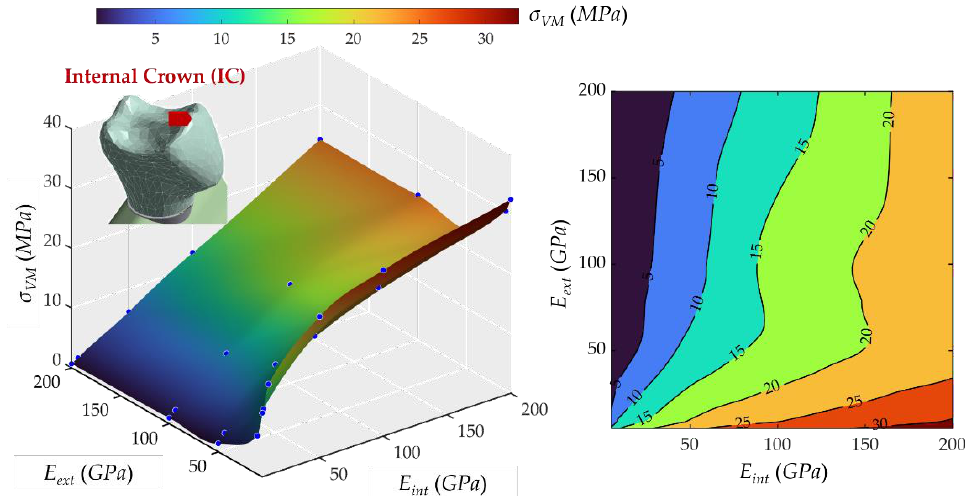
Figure 6. Von Mises maximum stress at the internal part of the crown, internal crown (IC). ( Left ): 3D representation. ( Right ): vertical projection.